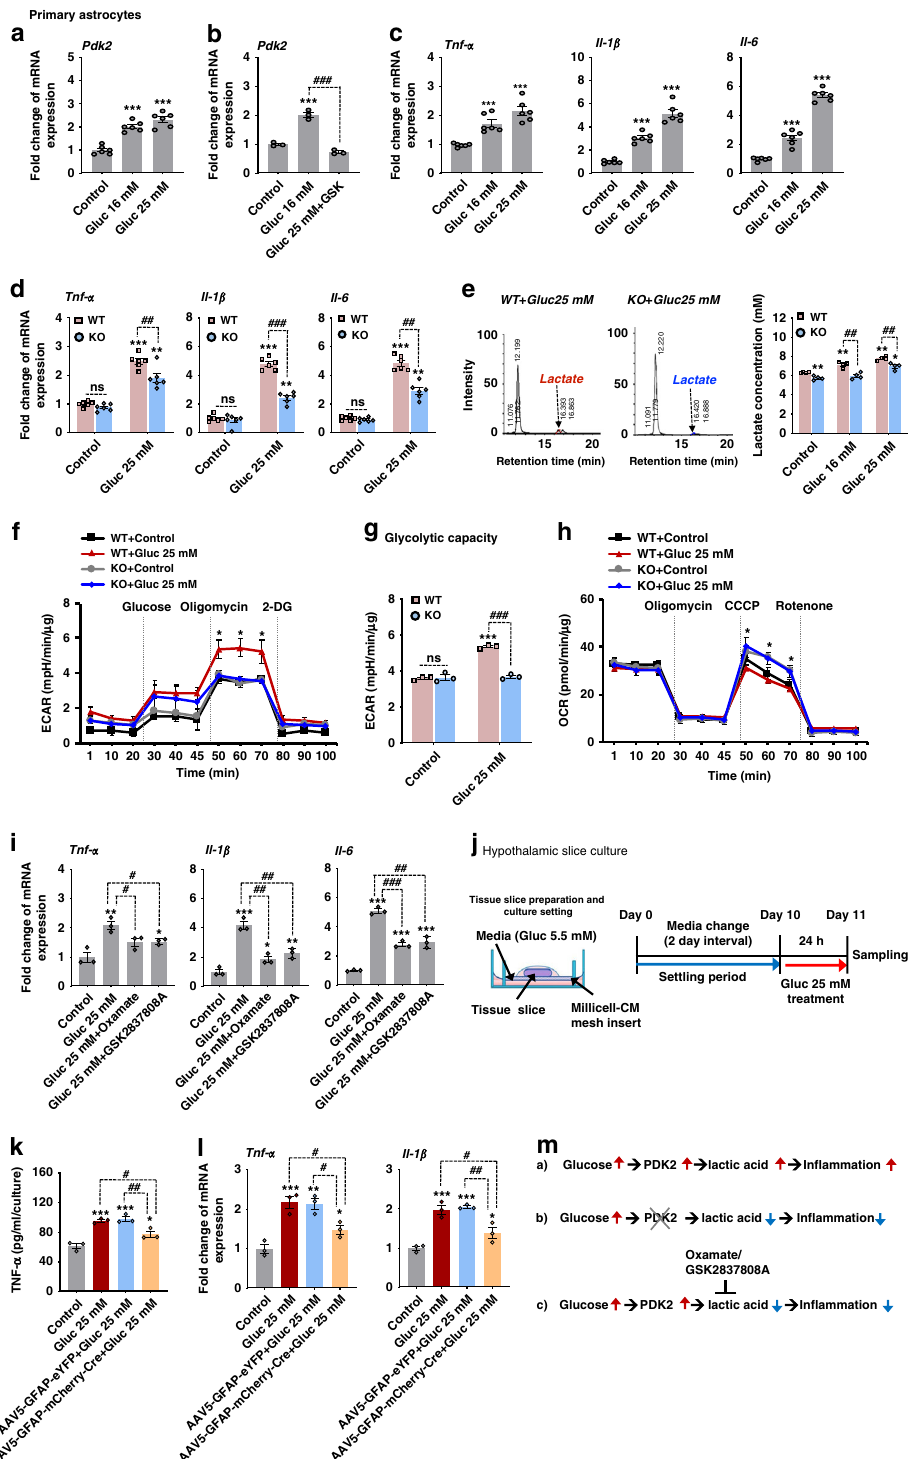
These fi ndings suggest that the hypothalamic PDK2-lactic acid axis plays a crucial role in local neuroin fl ammation and sub- sequent dysregulation of neuropeptide circuitry involved in feeding behavior in diabetes. PDK2 overexpression in the hypothalamus reverses the effects of Pdk2 de fi ciency in diabetes . To further examine the role of